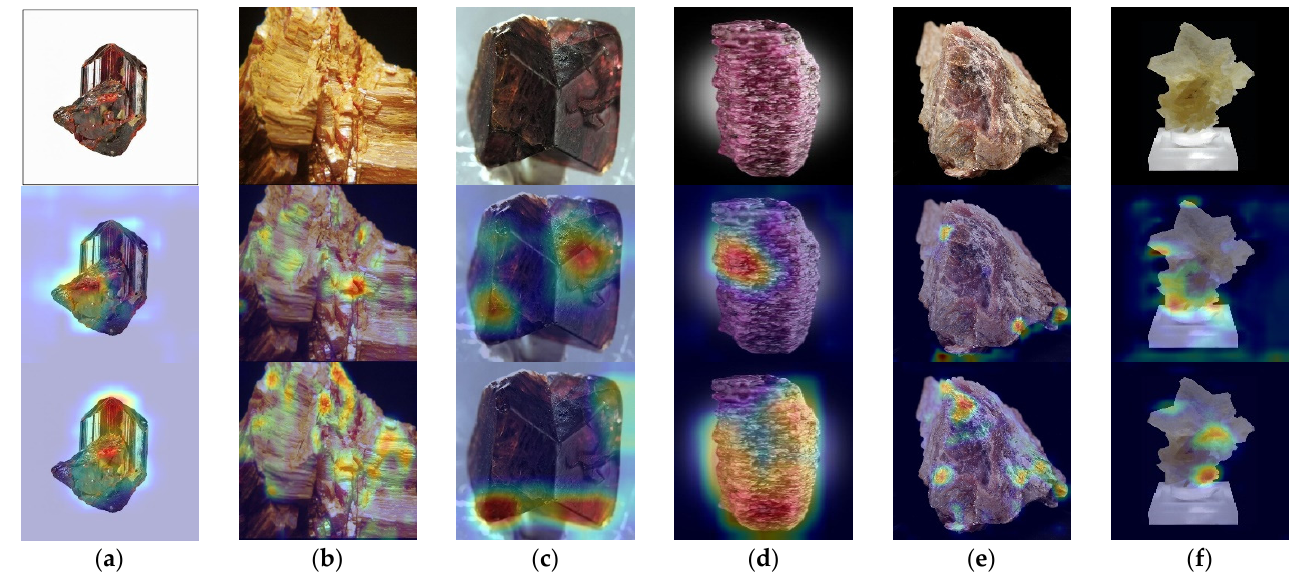
Figure 3. Grad-cam results using F 4 and fused features F 2 + F 4 based on ResNet-50. ( a ) Realgar; ( b ) Orpiment; ( c ) Spinel; ( d ) Corundum; ( e ) Muscovite; ( f ) Muscovite; the first row are original images, the second and third rows are Grad-cam results of F 4 and F 2 + F 4 recognition, respectively. In the second row, using F 4 , ( a – f ) are misrecognized as rhodochrosite, realgar, tourmaline, tourmaline, spinel, and calcite,